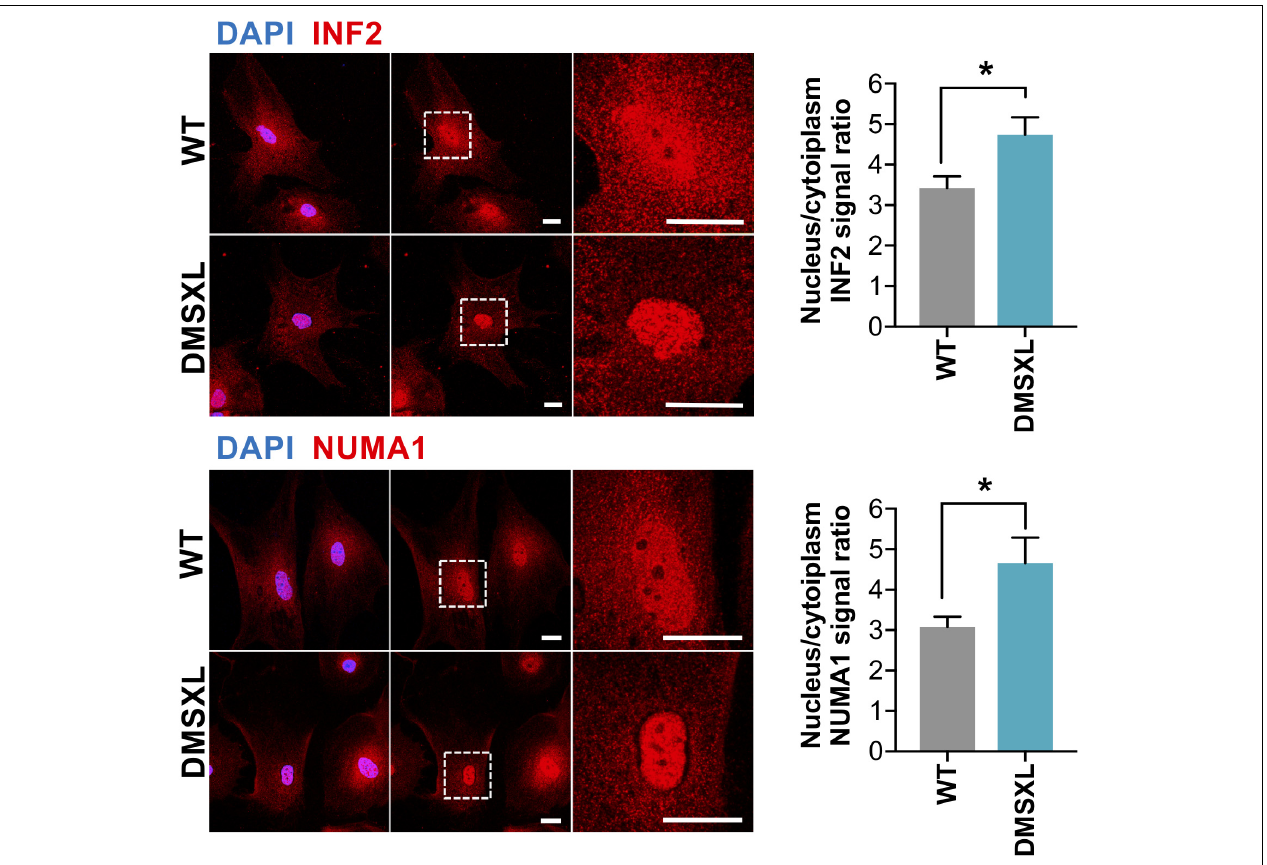
FIGURE 8 | Altered protein localization in DMSXL astrocytes. Representative confocal images and quantification of the distribution INF2 and NUMA1 proteins between the nucleus and cytoplasm in primary DMSXL and WT astrocytes. Protein signal was lower in the perinuclear cytoplasm of DMSXL astrocytes compared to WT controls cells. Scale bars represent 20 µ m (* p < 0.05; Student t -test U test; WT, n = 16 cells, DMSXL, n = 15 cells; 2 independent cultures per